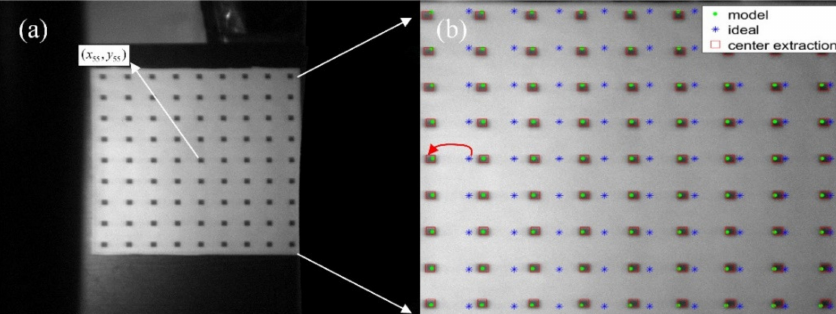
Figure 11. The experiment of the square target: ( a ) actual image of diffracted light at a polar angle of − 5.3 ◦ ; ( b ) the partially enlarged view of the square target.